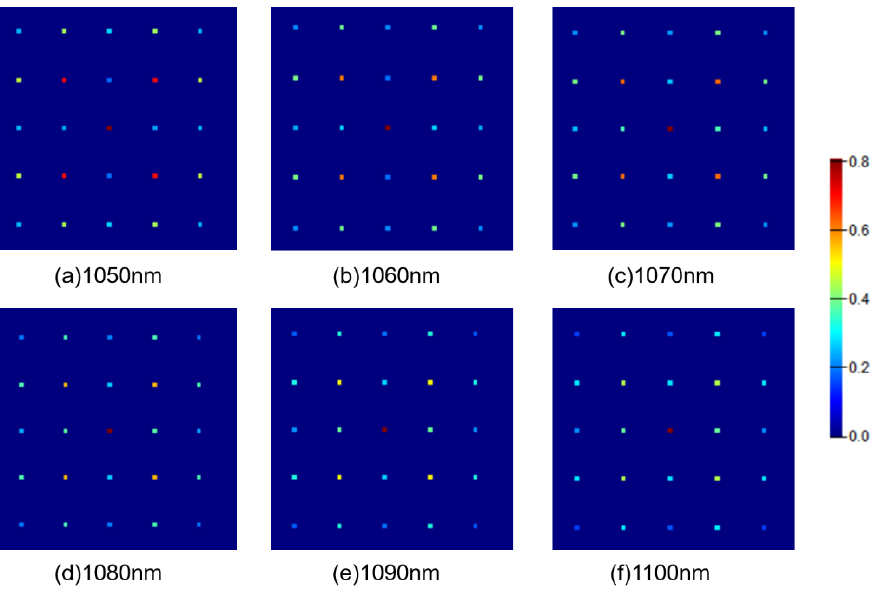
Figure 13. ( a – f ) Normalized light intensity distribution of the diffraction spots when plane waves with different wavelengths are incident.